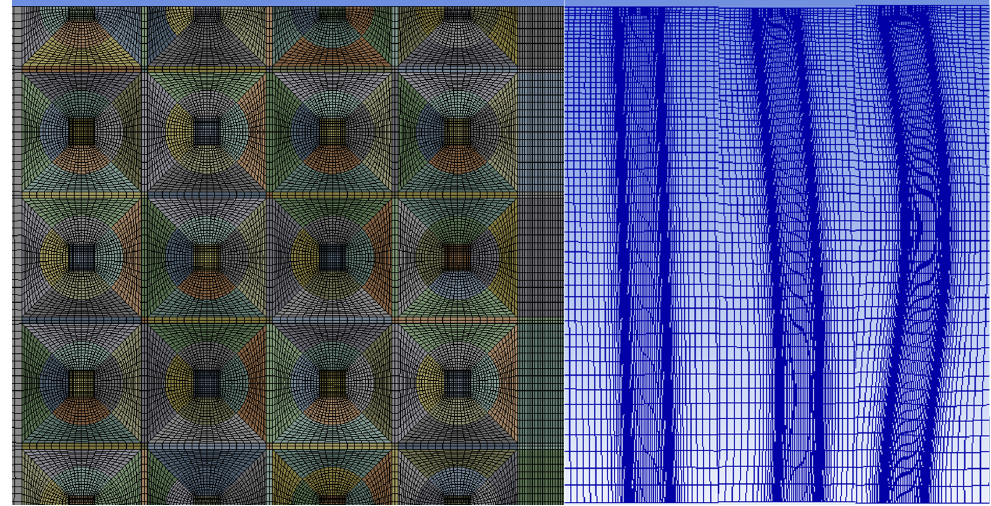
Figure 17. Numerical grid for the heat exchanger case and the first three modal shapes for each tube [60].